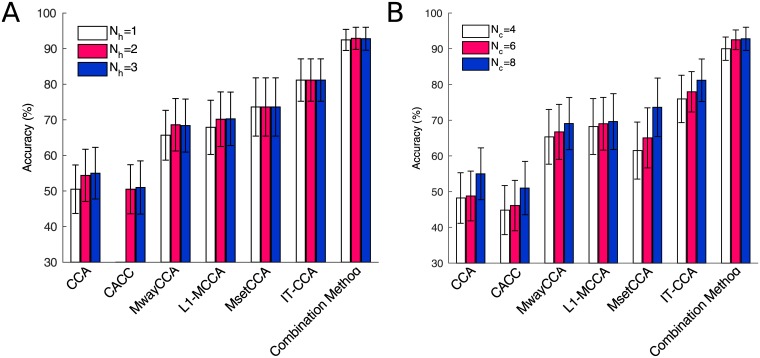
Comparison of accuracy with different parameters.Averaged classification accuracy for each method using (A) different numbers of harmonics (N
h in Eq (5)) and (B) different number of channels (N
c) across subjects. Error bars indicate standard errors.